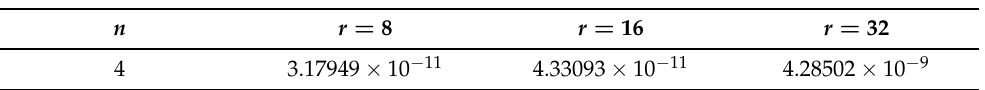
Table 6. (cid:107) x • − x ( n , r ) (cid:107) for Example 5 using the usual basis in L 2 [ 0,1 ] . n r = 8 r = 16 r =